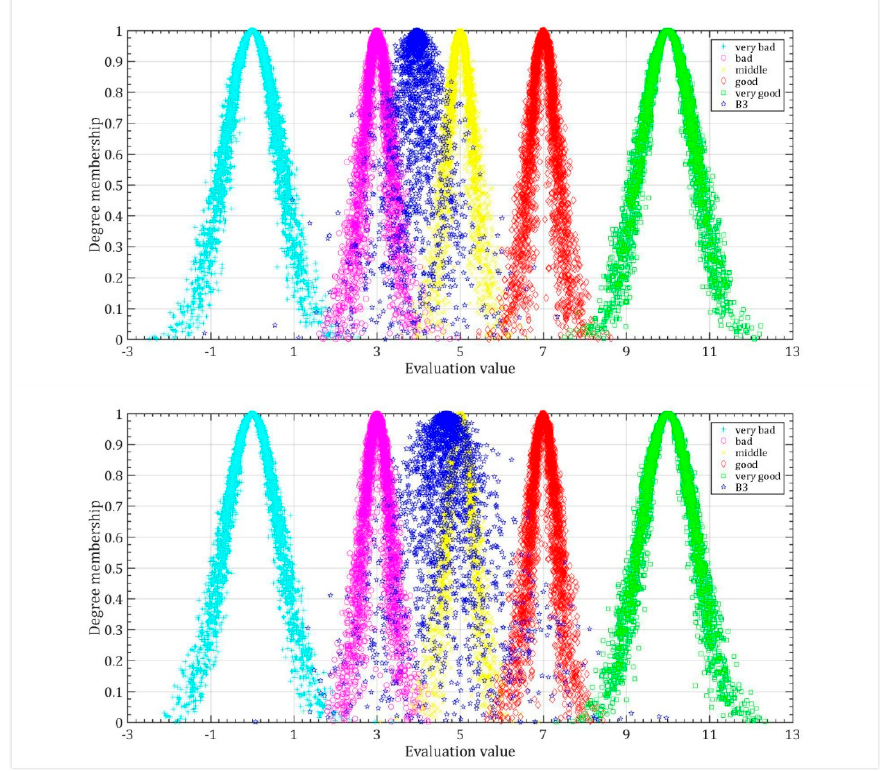
Figure 12. Cloud image of welfare evaluation grades of living environment of land-lost farmers’ households under different livelihood assets .